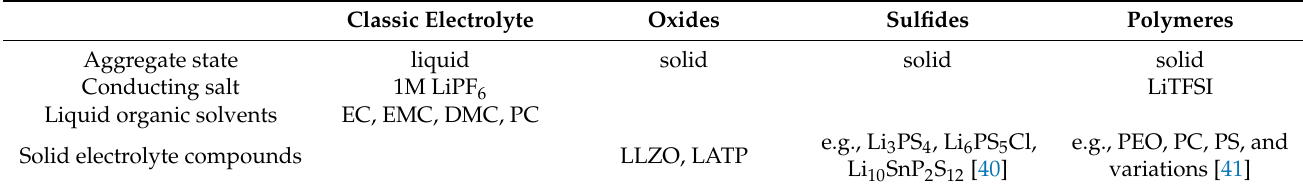
Table 2. Typical components and properties of separator